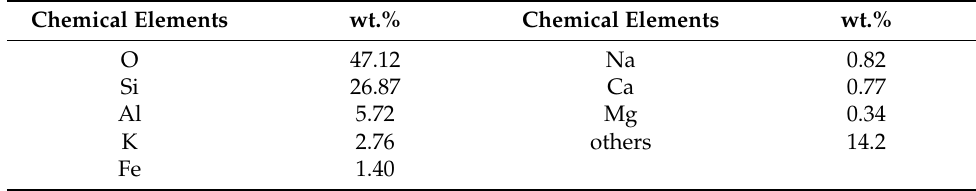
Table 2. Chemical compositions of the Chinese natural zeolites by